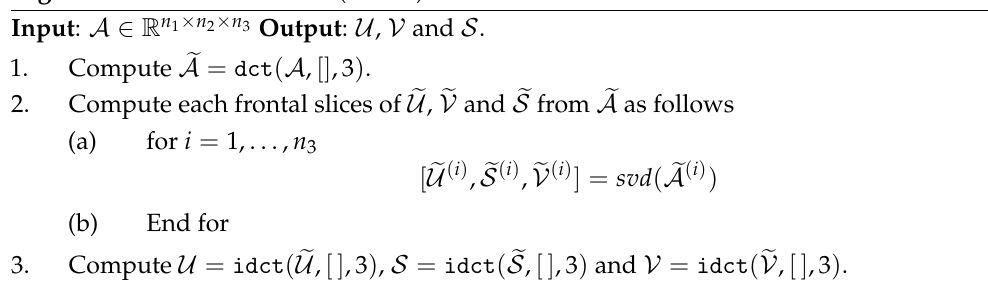
Algorithm 2 The Tensor SVD